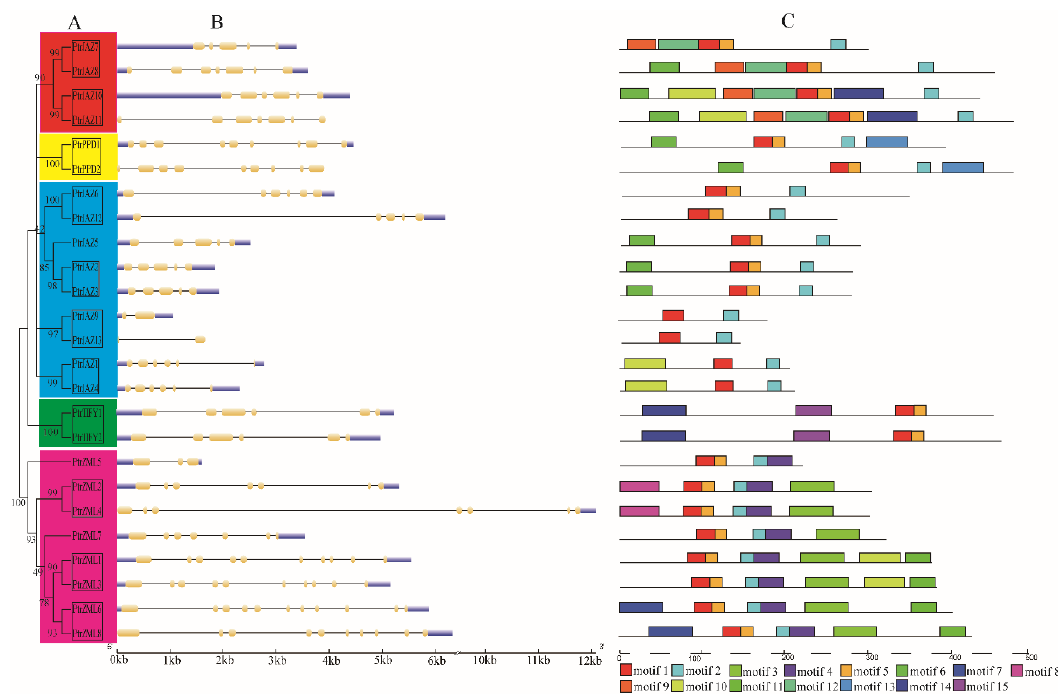
Figure 2. Phylogenetic relationships and gene structure of TIFYs in P. trichocarpa . (A) Multiple alignment of full-length amino acid sequences of PtrTIFY genes was carried out with ClustalX 2.0. The phylogenetic tree was constructed using neighbor-joining method with MEGA7.0. The sister pairs was marked with black-box. Red and blue boxes represent the JAZ subfamily, yellow box represents the PPD subfamily, green box represents the TIFY subfamily, and pink box represents the ZML subfamily. (B) Exon/intron structures of the PtrTIFY gene family. (C) The conserved motifs were obtained from the MEME website. Fifteen different kinds of conserved motifs were marked with different colors.